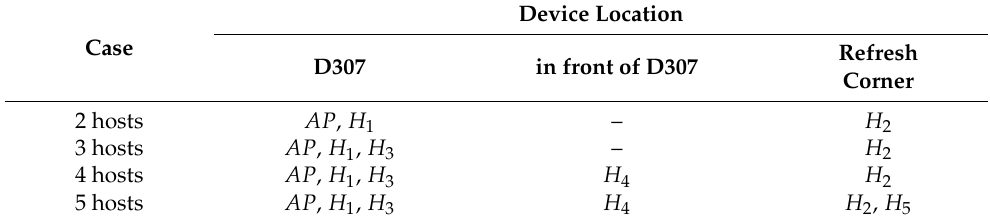
Table 4. Device locations.